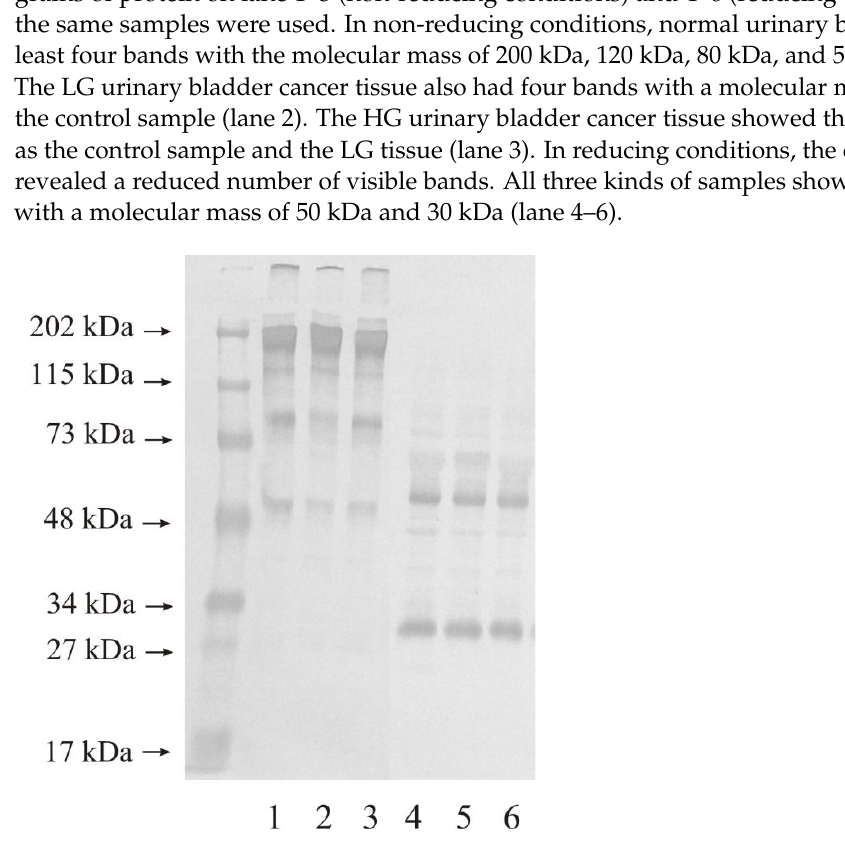
Figure 3. Western immunoblot of MMP-2 in control tissue and low-grade (LG) and high-grade (HG) urinary bladder cancer. An amount of 10 micrograms of protein, non-reducing conditions: lane 1 — control urinary bladder, 2 — low-grade bladder cancer, 3 — high-grade bladder cancer; 10 mi- crograms of protein, reducing conditions: lane 4 — control urinary bladder, 5 — low-grade bladder cancer, 6 — high-grade bladder cancer. It is a typical example of the WBs of the samples repeated five times.